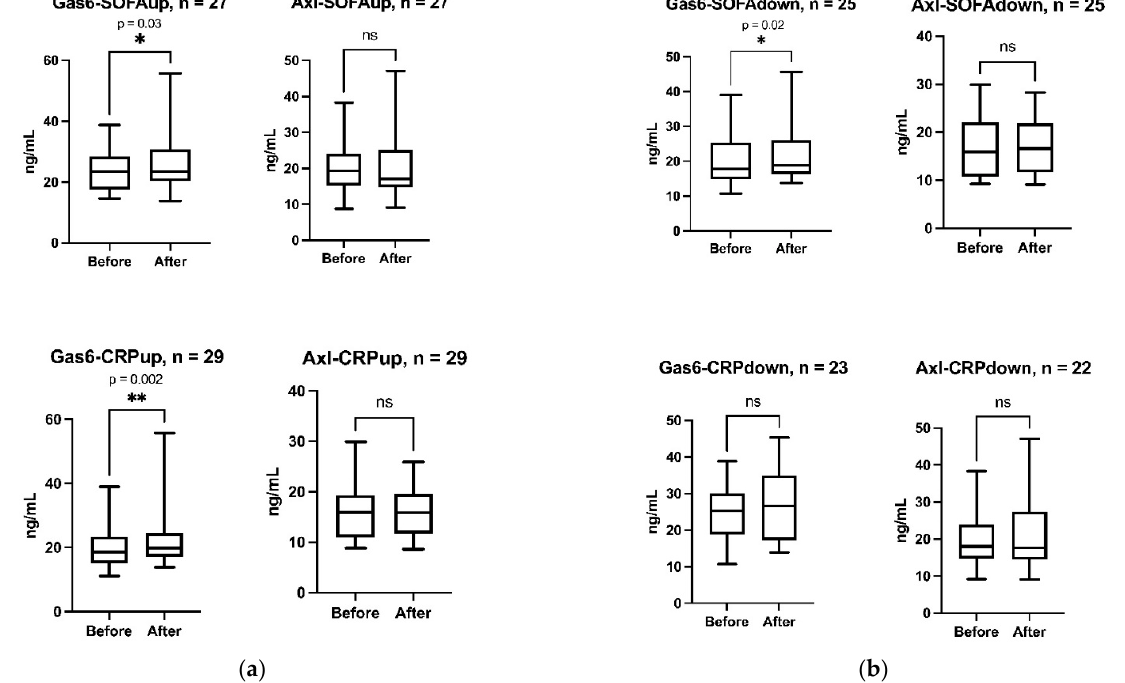
Figure 2. ( a ) Boxplots of Gas6 and sAxl (Axl) changes before and 24 h after vitamin K1 in patients with increased sequential organ failure assessment (SOFA; SOFAup) or C-reactive protein (CRP; CRPup). ( b ) . Boxplot s of Gas6 and sAxl (Axl) changes before and 24 h after vitamin K1 in patients with decreased SOFA (SOFAdown) or CRP (CRPdown). ** ( p = 0.002), * ( p = 0.02) and ns (no significant change).